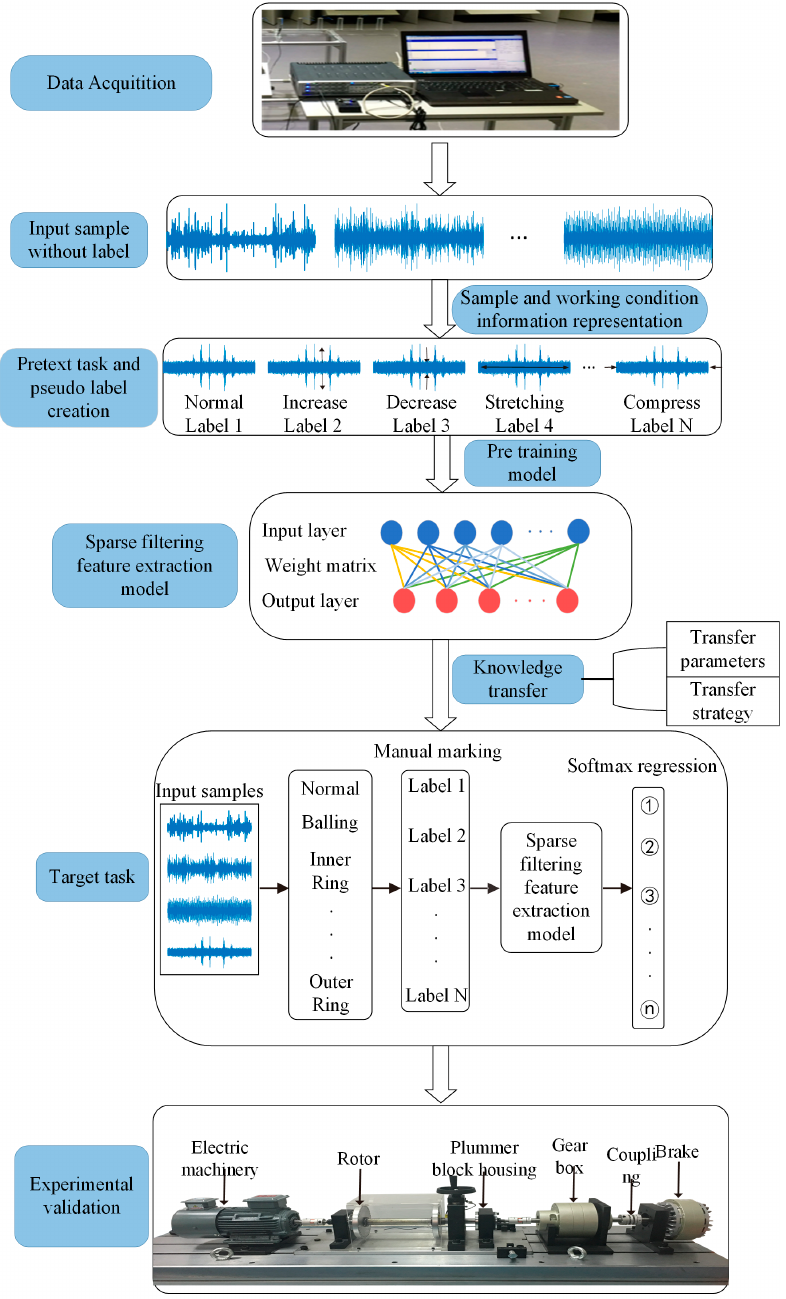
Figure 1. The details of the proposed self-supervised learning framework.